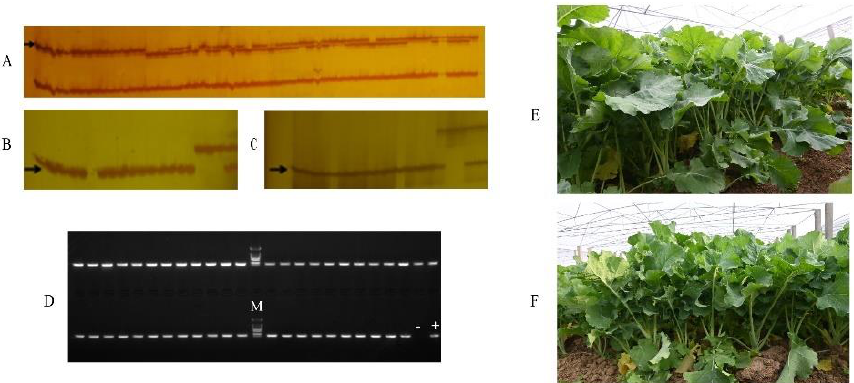
Figure 3. Polymorphism detection of markers in the BC 4 F 2 population. ( A ) Polymorphism detection of marker cnu_m090a. ( B ) Polymorphism detection of marker A08-300. ( C ) Polymorphism detection of marker sau_um353. Arrows indicate bands with homozygous resistance genotypes. ( D ) Polymor- phism detection of marker BnRFO-AS2; the picture shows the identification results of lines that are homozygous for the restorer gene and do not segregate. ( E ) Field phenotypic investigation of R2163. ( F ) Field phenotype investigation of the restorer line R2163R with clubroot disease resistance after improvement.